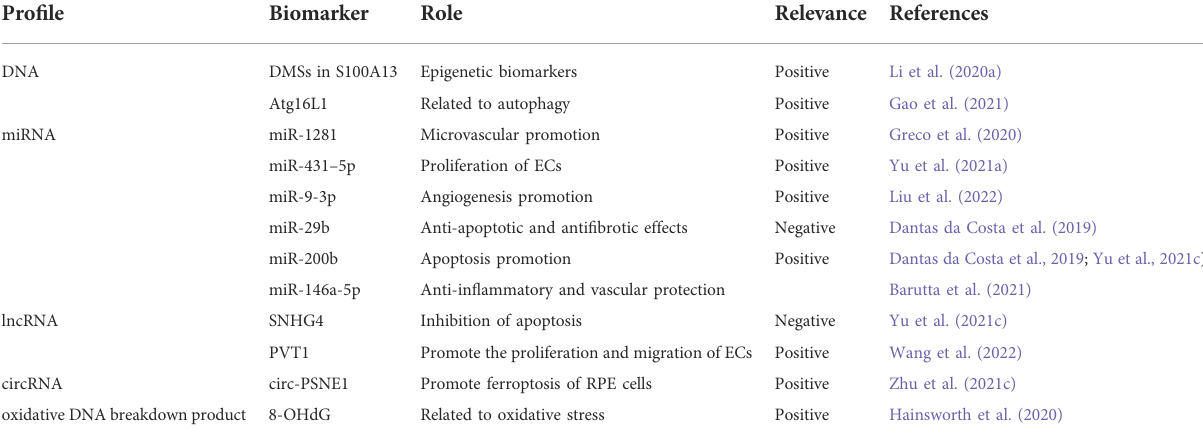
TABLE 3 Nucleic acid